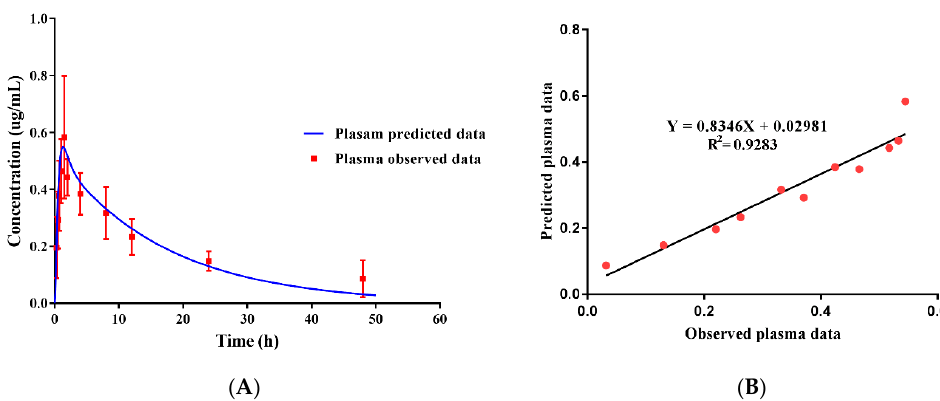
Figure 7. The fitting of observed plasma data with predicted data ( A ) and regression analysis of the PBPK model ( B ). The predicted plasma concentration was well fitted by the observed concentration ( r = 0.9635).